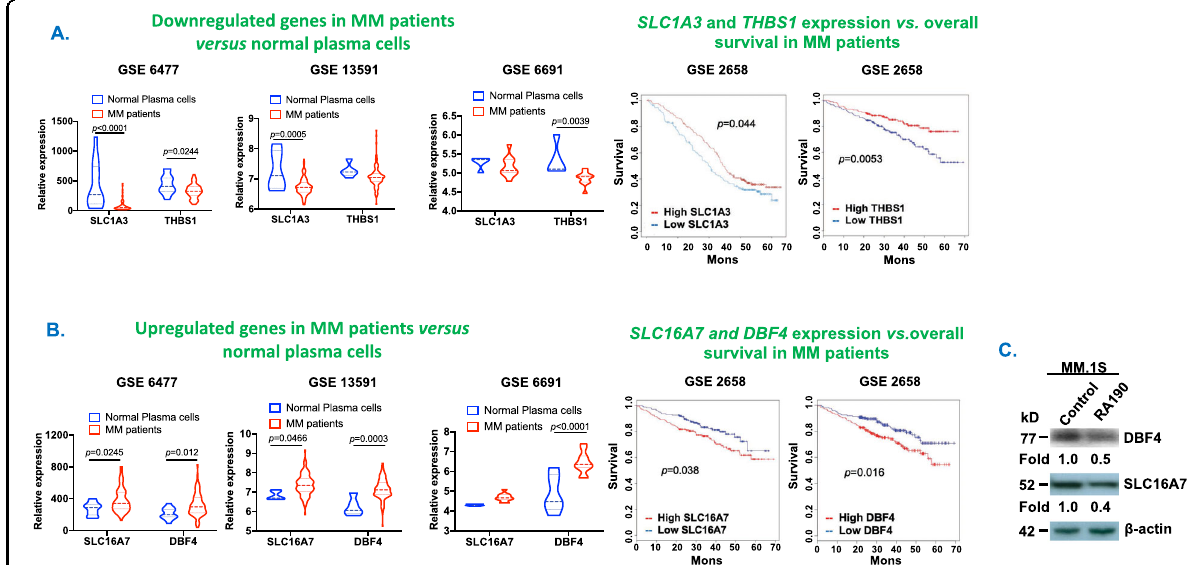
Fig. 2 Clinical relevance of SLC1A3, THBS1, DBF4, and SLC16A7 in MM. (A, box plot) Gene expression data collected using Affymetrix Human Genome U133A [HG-U133A] Array platform based on normal plasma cells ( n = 15)s and newly diagnosed MM ( n = 69) patient samples (data accession number GSE6477). Similar analysis was obtained using gene expression data in GSE13591 and GSE6691. The data are presented as relative gene expression of indicated genes in MM patient vs. normal. The analysis of data was based on the information available on the following websites: http://www.canevolve.org/AnalysisResults/AnalysisResults.html. (A, line graph) Kaplan – Meier plots on the prognostic relevance of SLC1A3 and THBS1 gene expression on the overall survival of uniformly treated MM patients: patients with low SLC1A3 and THBS1 expression (blue line) had shorter survival, whereas patients with elevated SLC1A3 and THBS1 (red line) had longer survival. The gene expression analysis is based on Total Therapy-2 patients survival data collected using [HG-U133-Plus 2] Affymetrix Human Genome U133 Plus 2.0 Array platform (Data accession number GSE2658). (B, box plot) Gene expression data collected using Affymetrix Human Genome U133A [HG-U133A] Array platform based on normal plasma cells ( n = 15) and newly diagnosed MM patient samples ( n = 69) (data accession number GSE6477). Similar analysis was obtained using gene expression data on GSE13591 and GSE6691. Relative gene expression of indicated genes in MM patient samples vs. normal plasma cells is presented and data analysis was based on information from websites in ‘ A ’ . (B, line graph) Kaplan – Meier plots on the prognostic relevance of SLC16A7 and DBF4 gene expression on overall survival of MM patients: patients with elevated SLC16A7 and DBF4 expression (red line) had shorter survival, whereas patients with low SLC16A7 and DBF4 expression (blue line) had longer survival. The gene expression analysis is based on Total Therapy-2 patients survival data collected using [HG-U133-Plus 2] Affymetrix Human Genome U133 Plus 2.0 Array platform (data accession number GSE2658). (C) MM.1S cells were treated with DMSO control or RA190 (0.5µM) for 16h; total protein extracts were subjected to immunoblot analysis using antibodies against DBF4, SLC16A7, or β -actin. Protein bands in immunoblot were quanti fi ed by densitometry using ImageJ and normalization with β -actin. Blots shown are representative of three independent experiments. Student ’ s t -test was utilized to derive statistical signi fi cance (Graph Pad PRISM version 6, La Jolla, CA,